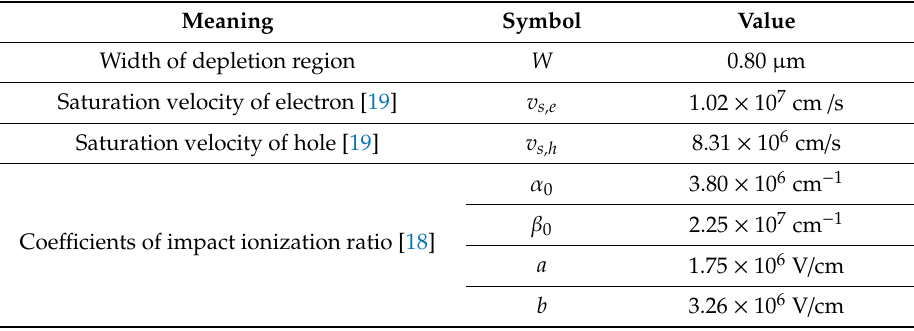
Table 1. Symbols and values of the physical constant